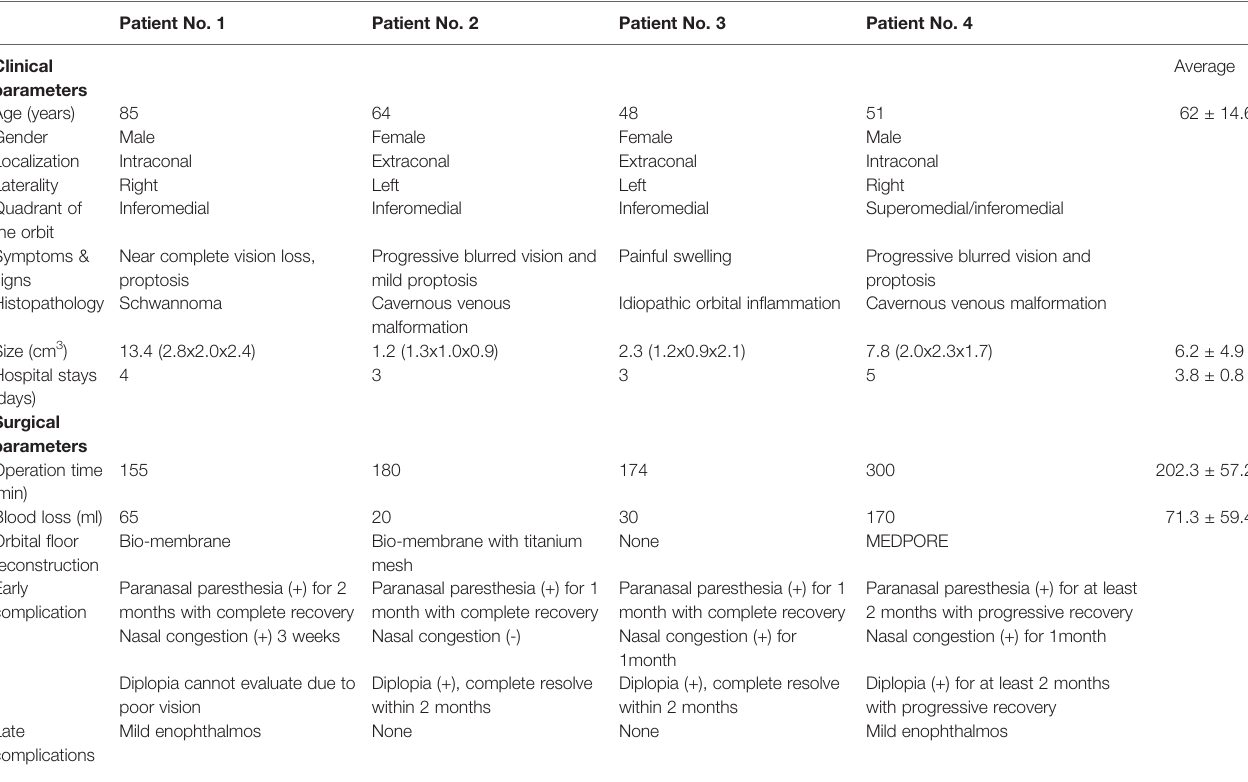
TABLE 1 | Clinical characteristics and surgical parameters. Patient No.